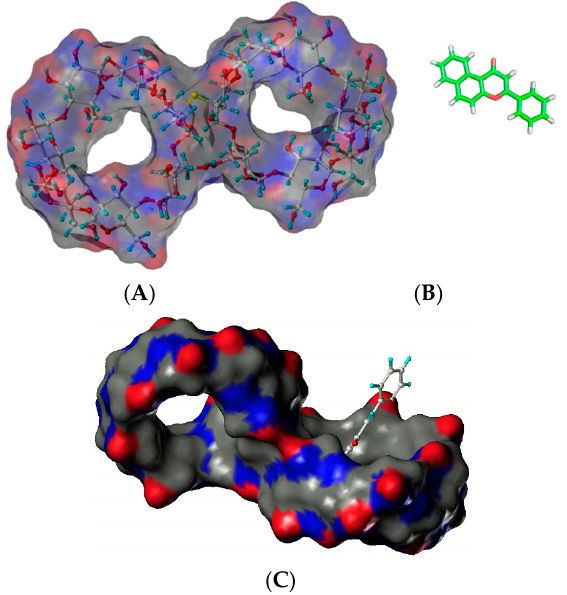
Figure 5. Structures of β -CD dimer ( A ) and β -naphthoflavone ( B ). The proposed mode of complex ( C ) [8].